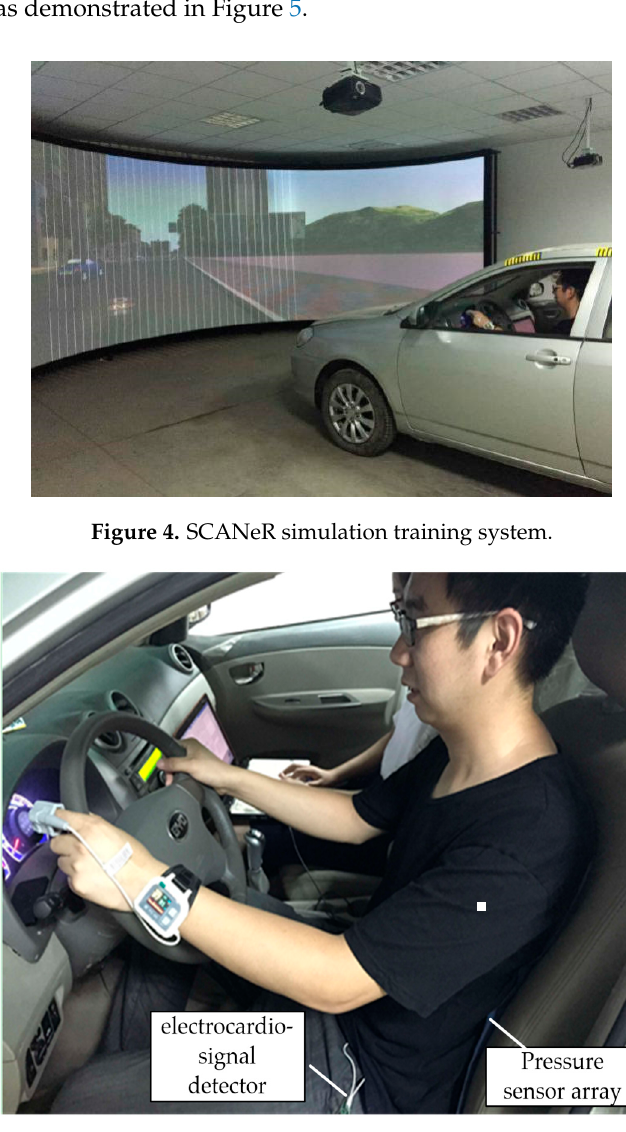
Figure 5. Equipment installation.